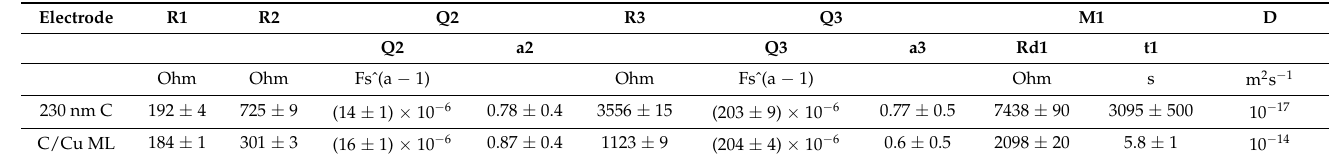
Table 2. Values of the equivalent circuit elements obtained from fitting the measured EIS data presented in Figure 9k,l. The EIS measurements were performed in the delithiated SOC after the 30th cycle of the C/Cu ML (Figure 9k) and 230 nm carbon thin film (Figure 9l) electrode, i.e., after the five CC cycles with the highest current density during the rate capability experiments. The equivalent circuit is presented in Figure 9k. The last column lists the Li diffusivities obtained from the EIS analysis. The parameters (Q and a) describe the constant phase element, where the constant phase is given by ( − 90 · a). The parameters Rd1 and t1 describe the restricted diffusion element M1 which is used for finite-length linear